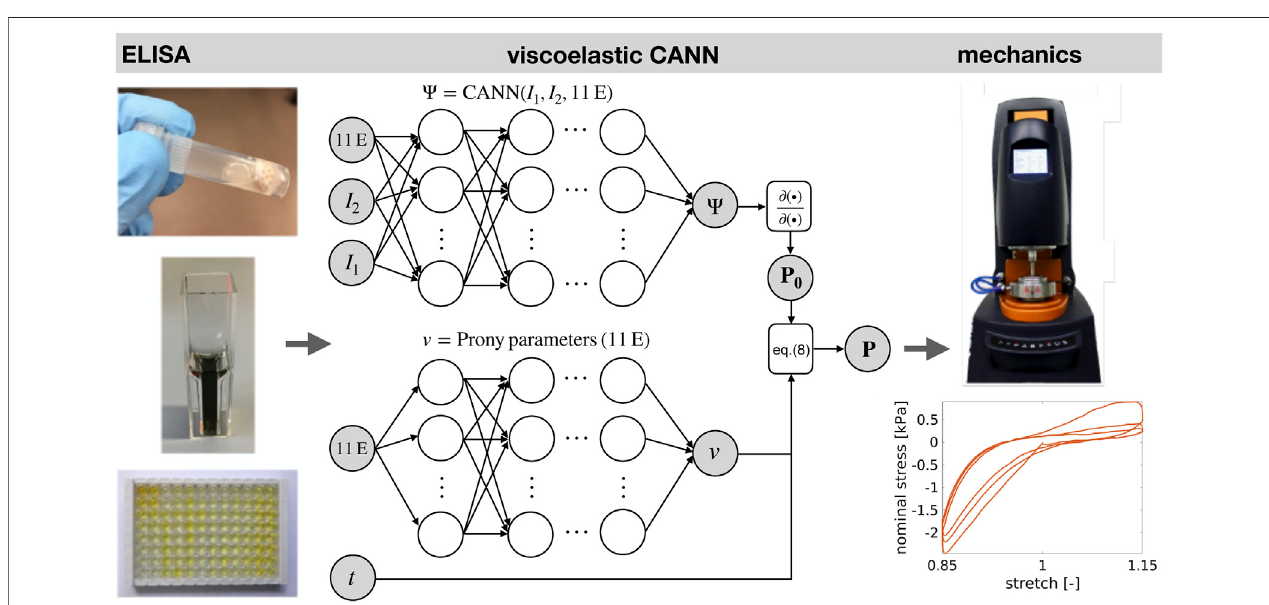
FIGURE 3 | 11 ELISA parameters (11 E) and strain data from mechanical tests (in the form of invariants I 1 , I 2 , ... ) form the input of an extended type of constitutive arti fi cial neural network. Machine learning adjusts its stress output to the one measured experimentally. Thereby, the neural network learns to describe the mechanical behavior of brain tissue and to predict it from the ELISA parameters. The extended CANN consists of a standard CANN block and a parallel deep neural network computing the Prony parametersof the viscoelastic constitutive behavior. Note that the stress response P is computed by a recursive update in time t . The hidden neurons in the network are illustrated as blank circles, while the associated network weights are depicted as black arrows.